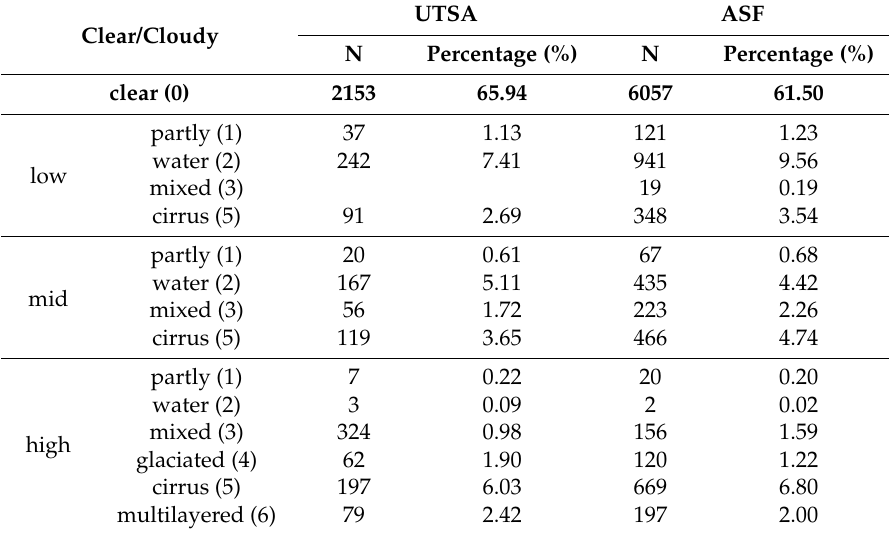
Table 2. The number and percentages of occurrence of clear-sky and cloudy-sky